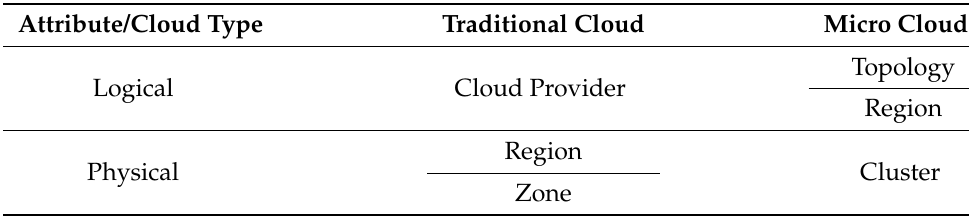
Table 1. Comparison between traditional cloud and micro cloud